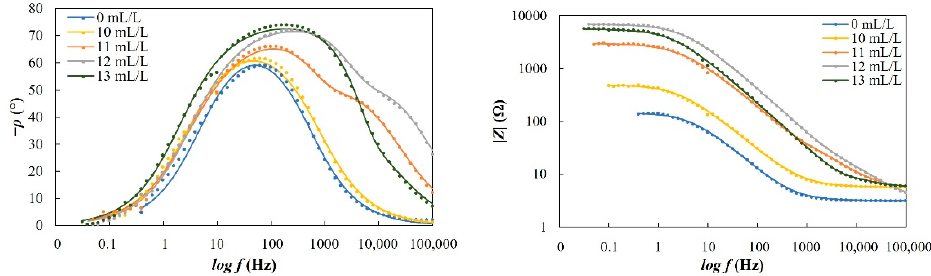
Figure 6. Bode plots scanned on the carbon-steel sample in the simulated brine saturated with CO 2 with and without the inhibitor in static conditions (Adapted from [24]).